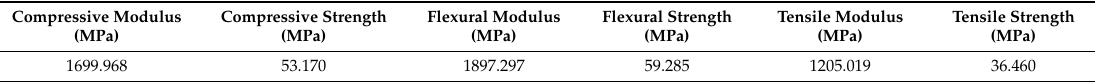
Table 2. Photosensitive resin mechanical